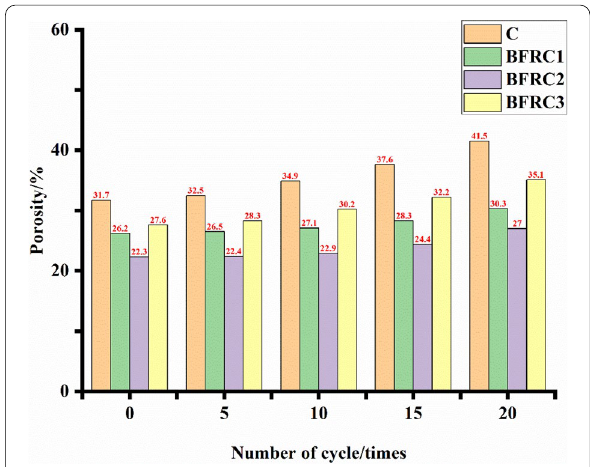
Fig. 11 The porosity of concrete at different single-side salt-freezing–drying–wetting